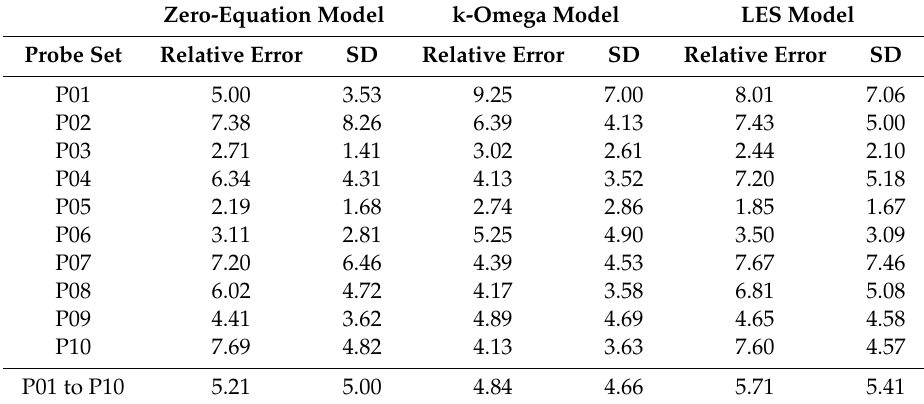
Table 5. Time-averaged relative error, in %, and its SD of the ten probe